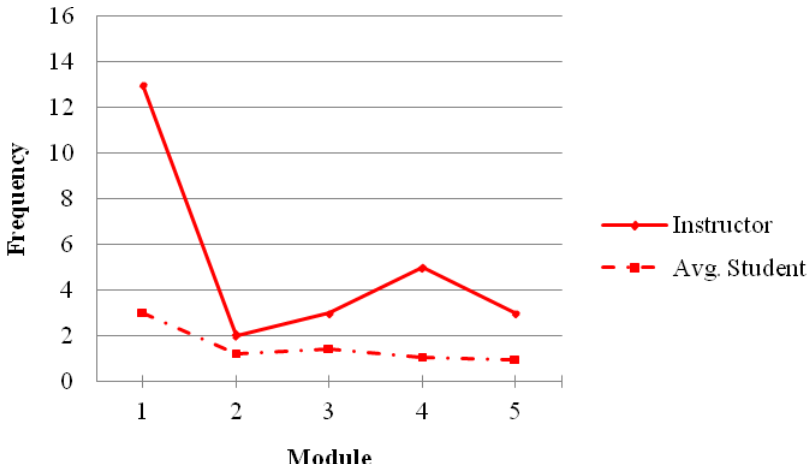
Figure 2 . Course A: Instructor TP versus average student TP.